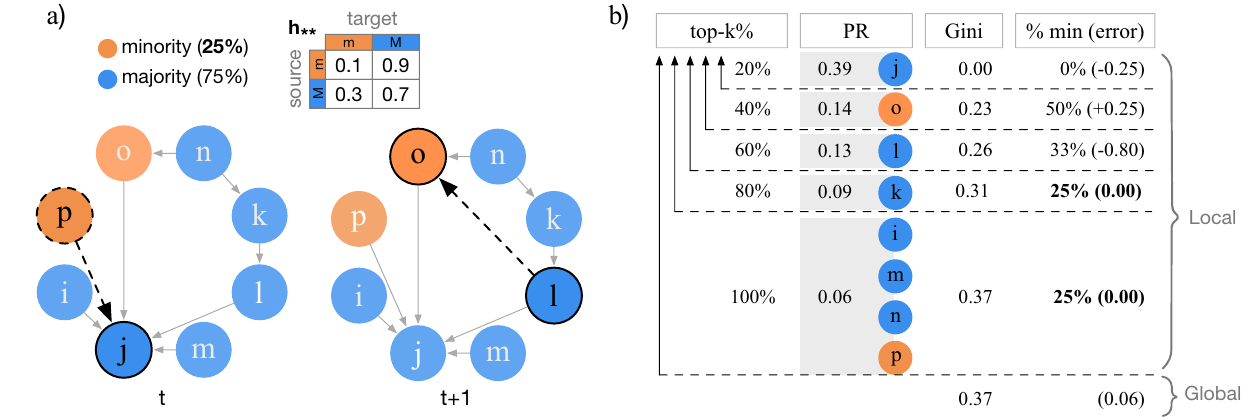
Figure 3. DPAH model and ranking of nodes. ( a ) Illustration of the directed network model with preferential attachment and homophily (DPAH). First, n = 8 nodes are created and randomly labeled according to the fraction of minorities f m = 0.25 . Then, the following algorithm repeats until a desired edge density is fulfilled. At time t , a source node p is drawn from a power-law (activity) distribution, and a target node j is drawn with a probability proportional to the product of its in-degree K in j = 4 and the pair-wise homophily h pj = h mM = 0.9 . At time t + 1 , a new edge is added between nodes l → o based on the same mechanism. ( b ) The PageRank score of each node is shown under PR . Nodes in each top-k% of the rank are grouped based on the unique PageRank scores. In this example, the top-60% of nodes concentrate most of the PageRank and their scores are somewhat similar (i.e., low Gini). Also, the ranking is fair from top-80% onwards, since they capture the same fraction of minorities as in the population, 25%. Local values are measured per top-k%, and global values are measured using the whole distribution for inequality (Gini), and the average across all top-k% ranks for inequity (mean